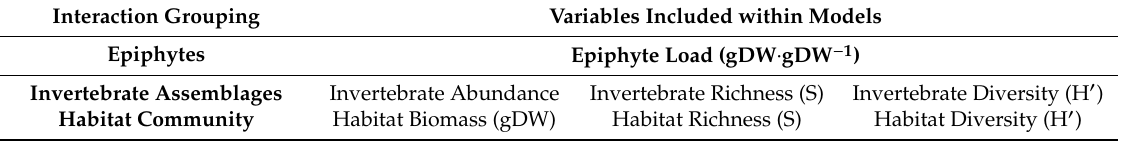
Table 1. The variables measured within the study for each of the three levels within the invertebrate– seagrass–epiphyte interaction. Each variable was modelled using all variables from the groupings below it, e.g., epiphyte load (gDW · gDW − 1 ) was modelled using all invertebrate and habitat community